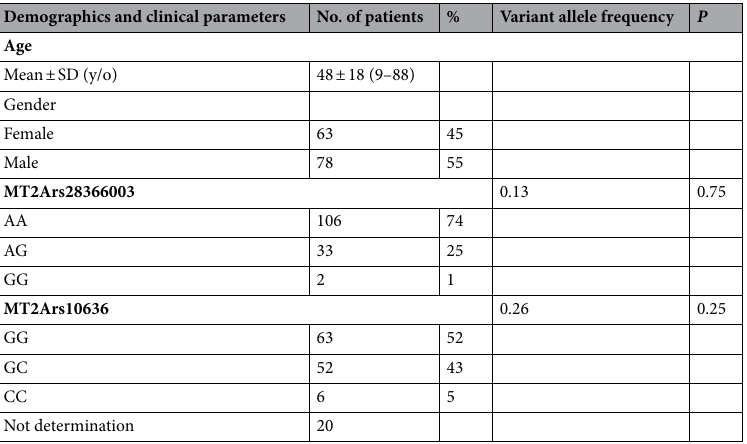
Table 1. Demographics and MT2A genotypes of 141 residents and to determine whether observed genotype frequencies are consistent with Hardy–Weinberg equilibrium in Taiwan. If P < 0.05, it is not consistent with Hardy–Weinberg equilibrium. Not accurate if < 5 individual in any genotype